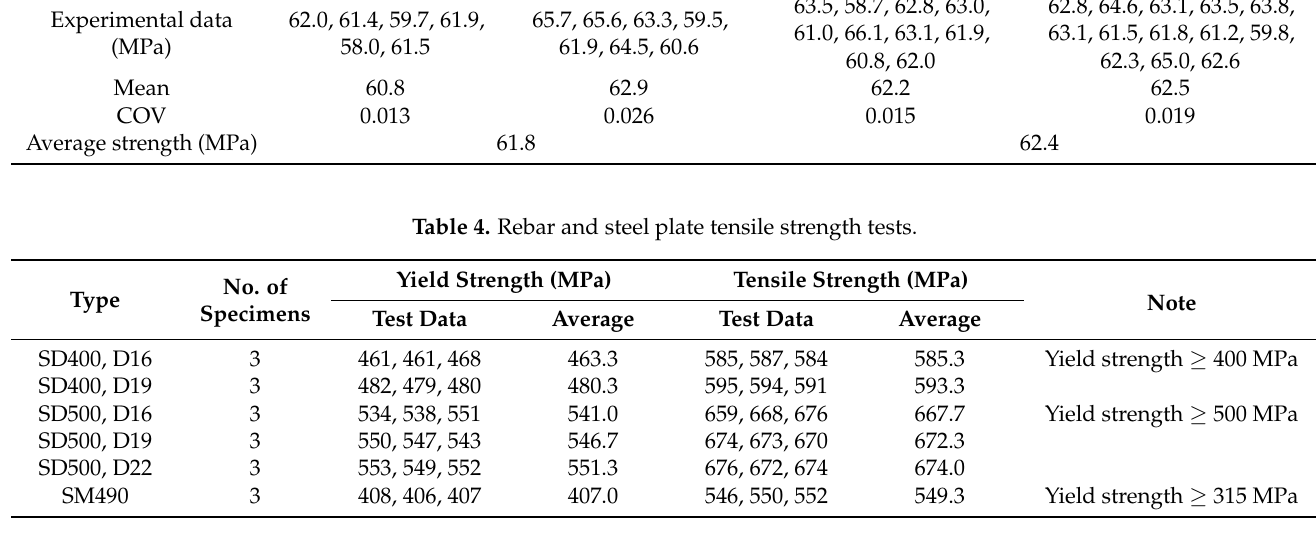
Table 4. Rebar and steel plate tensile strength tests.